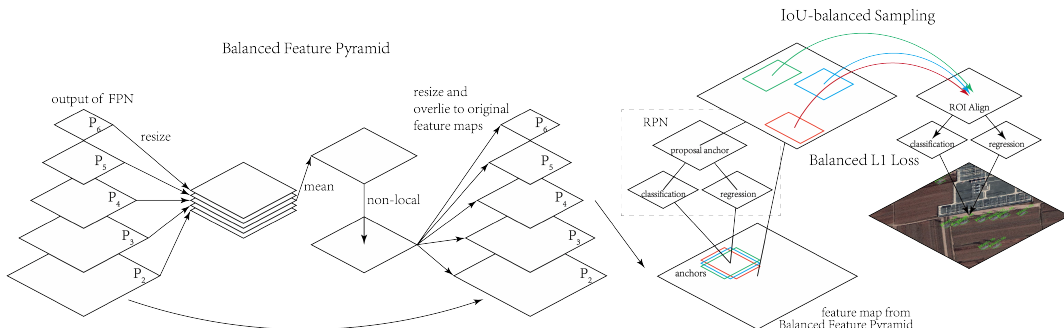
Figure 8. Structure of Libra RCNN [39]. Libra R-CNN updates the output of FPN [43], P 2 – P 6 , with Balanced Feature Pyramid and the updated feature maps are imported to next structure. Tetragons with different colors represent different anchors. RPN (Region Proposal Network) is a fully convolutional network, classify the anchors to foreground/background and regress the bounding-box sketchily. ROI is the abbreviation of region of interesting and ROI Align layer [21] is used to reconcile the size of feature maps. Libra R-CNN utilizes IoU-balanced Sampling to sample the anchors and Balanced L1 Loss to calculate classification loss. Details of Balanced Feature Pyramid, IoU-balanced Sampling, and Balanced L1 Loss can be found in [39].